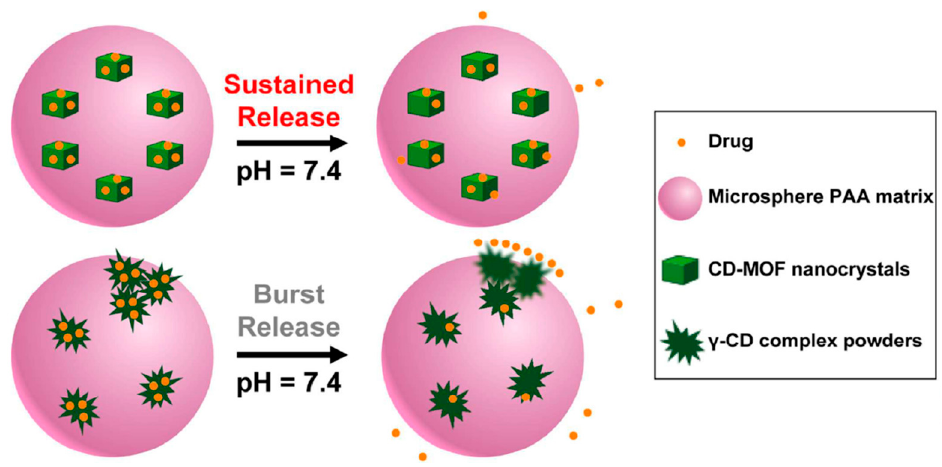
Figure 6. Illustration of burst and sustained drug release mechanisms of γ -CD complexes and CD-MOFs within PAA matrix. Reprinted with permission from [84], Copyright RSC, 2017.